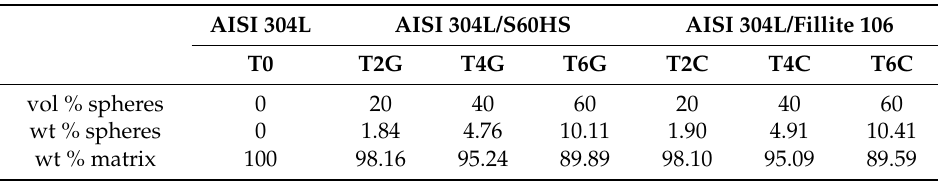
Table 2. Compositions of the material batches (in vol % and wt